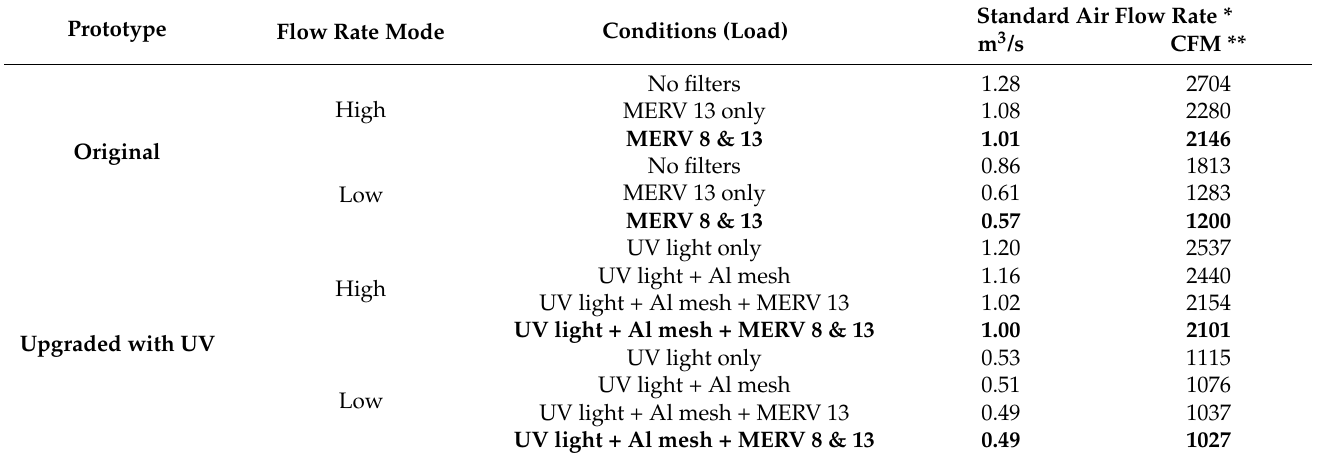
Table 1. Summary of air flow rate (converted to standard air flow rate) of the FastAir device under different conditions. Bold values refer to the conditions that test the performance of the entire